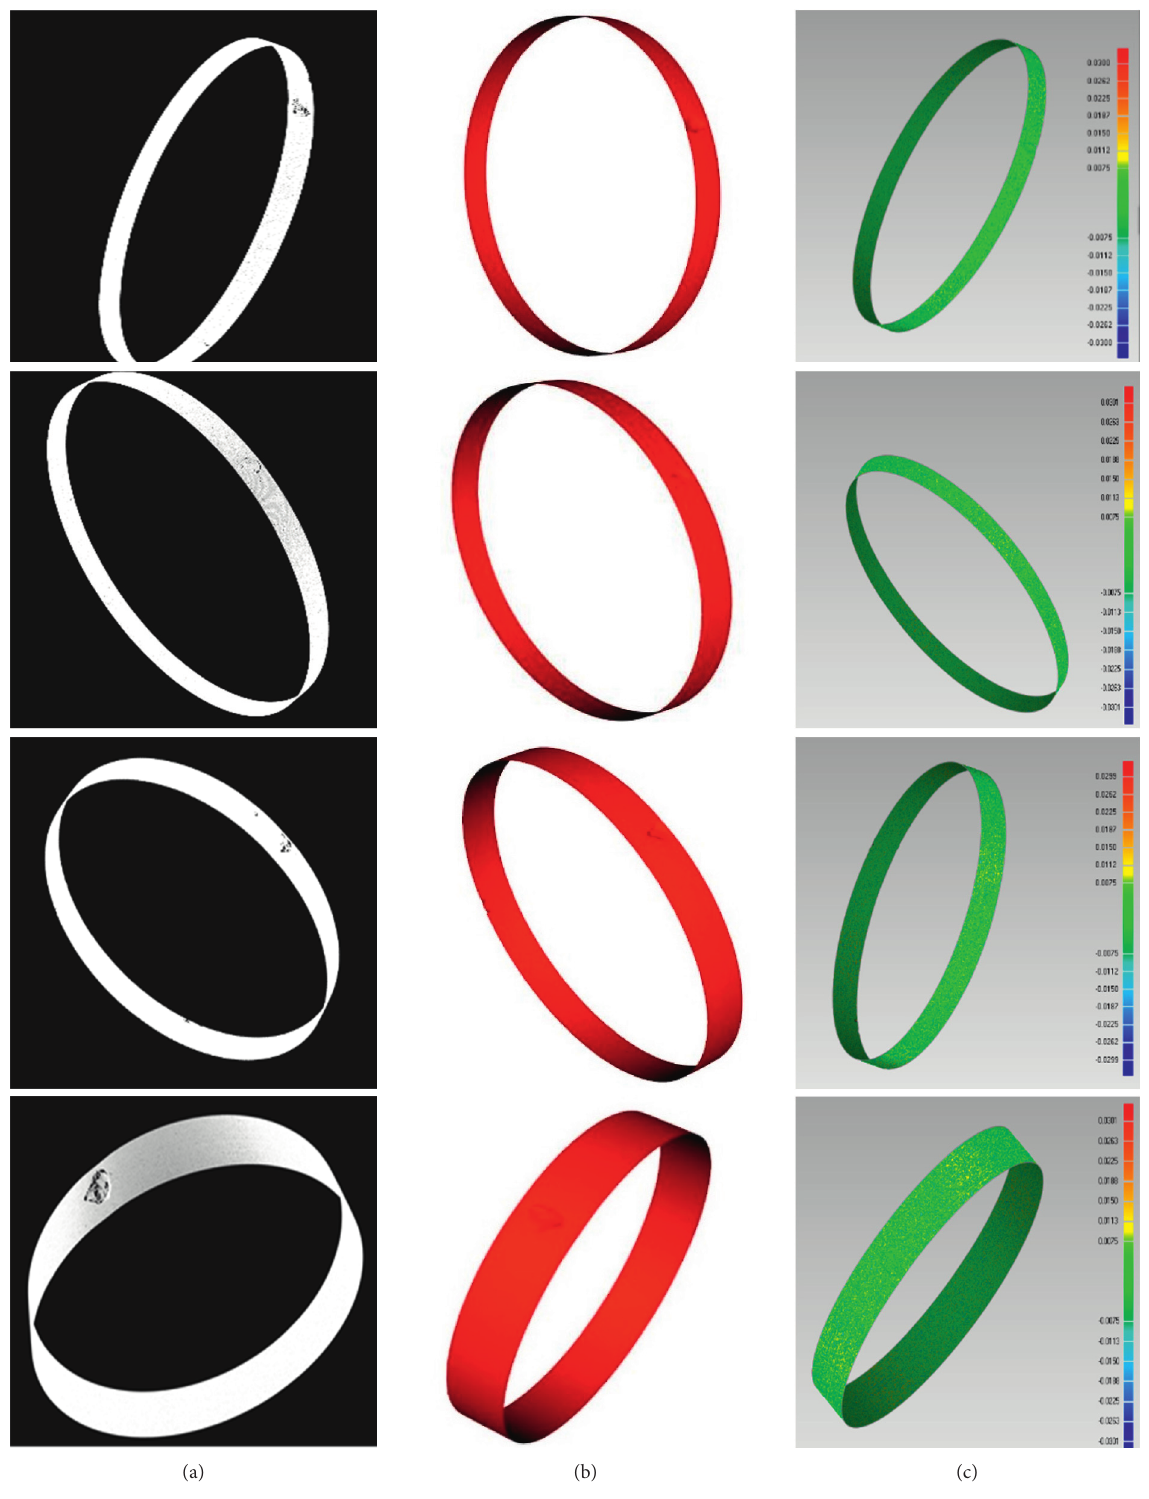
Figure 10: Point cloud reconstruction and deviation diagram of different fatigue roller contact surfaces. (a) Point cloud before recon- struction of different roller contact surfaces, (b) reconstruction results of different roller contact surfaces, and (c) reconstruction deviation diagram of different roller contact